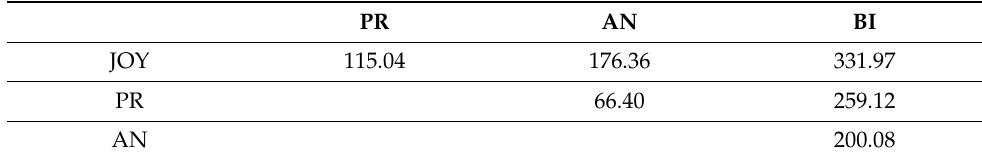
Table 9. Chi-square difference results (the second wave): The Chi-square differences of the items all exceeded 3.84, showing that the discriminative validity fell in an acceptable range. PR AN BI JOY 115.04